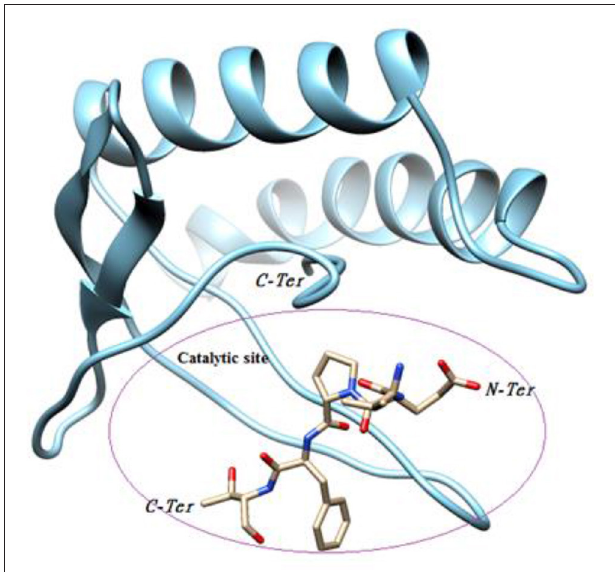
FIGURE 7 | Substrate binding studies on the surface of